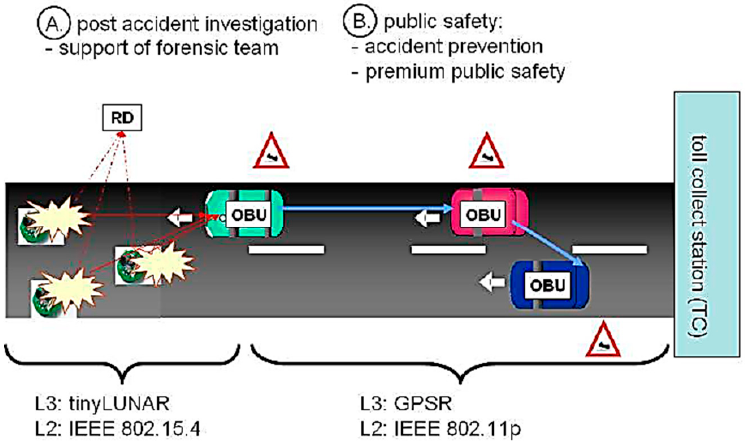
Figure 20. An illustration of the WSN deployed for an Intelligent Transport system [56].